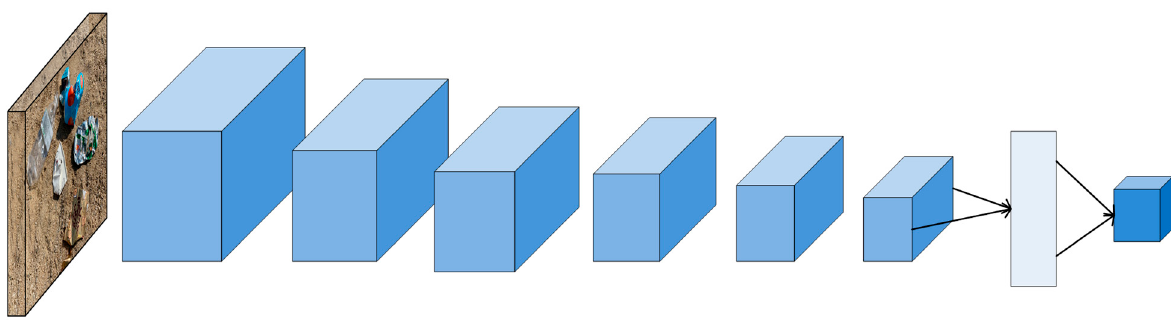
Figure 1. The basic structure of YOLO